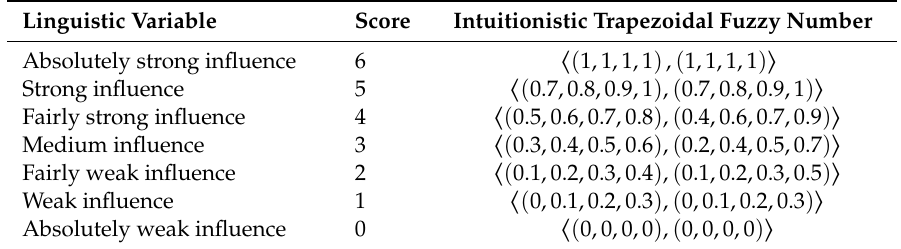
Table 1. Linguistic variable and fuzzy number for the degree of influence.